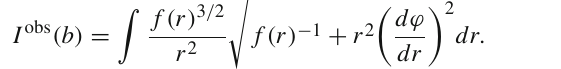
emissions, observed emissions, and two-dimensional optical appear- ance, respectively. The numerical values of parameters for all profiles are defined in set 2 and the mass of BH as M =